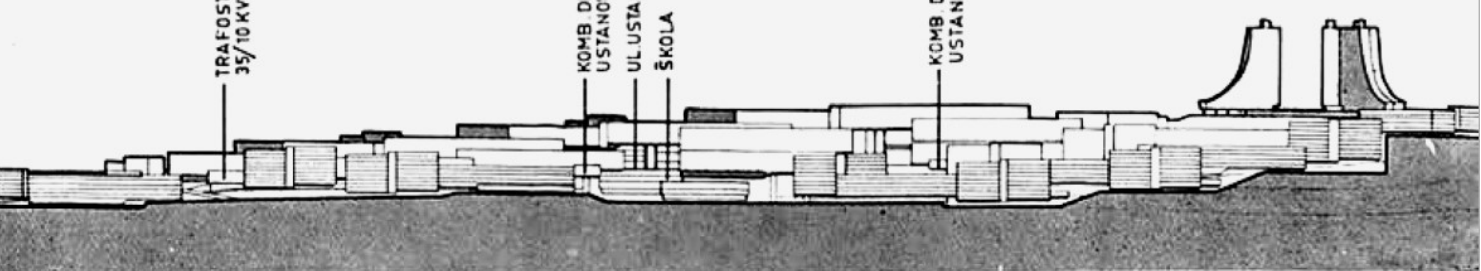
Fig. 7 Detail of the cross-section through Konjiarnik complex showing the functional organi- zation of the plynth onto which rise the three